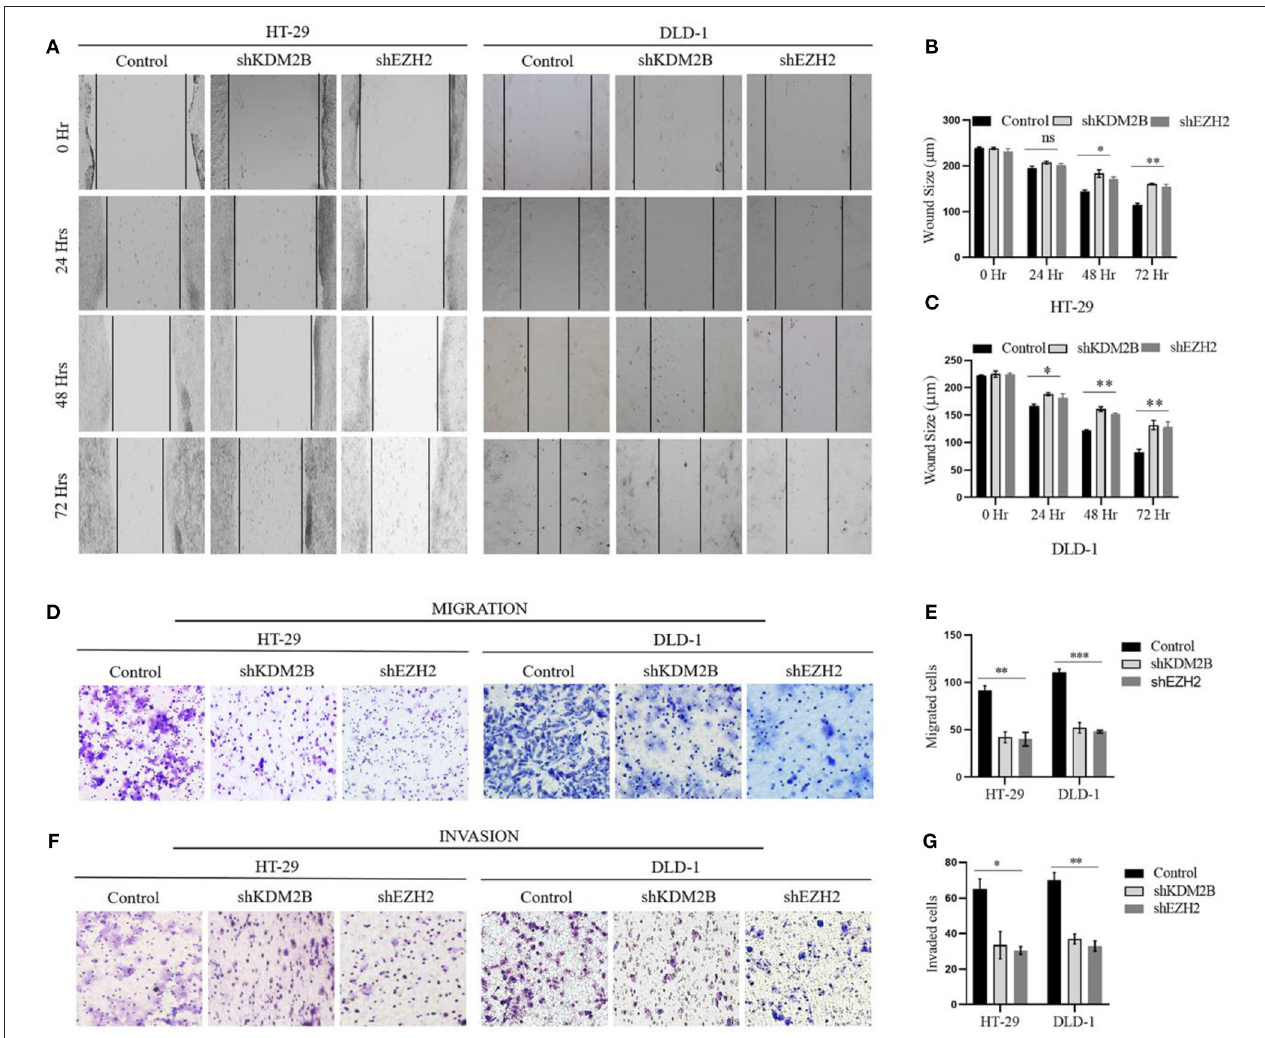
FIGURE 6 | The downregulation of KDM2B and EZH2 inhibits the migration and invasion in CRC cells. HT-29 and DLD-1 cells were treated with either shKDM2B or shEZH2. (A–G) The migration and invasion abilities of the cells were examined by scratch wound healing assay, migration, and invasion assay (Transwell assay). (A) A representative image of the wound area after the scratched wound healing assay. (B,C) The cluster bar chart of the wound area in µ m at various time points. (D,F–H) Representative pictures and the cluster bar chart of migrated and invaded HT-29 and DLD-1 cells. The data was statistically significant at * p < 0.05, ** p < 0.01, *** p < 0.001 as compared to control. Data are represented as mean ± SEM of three independent